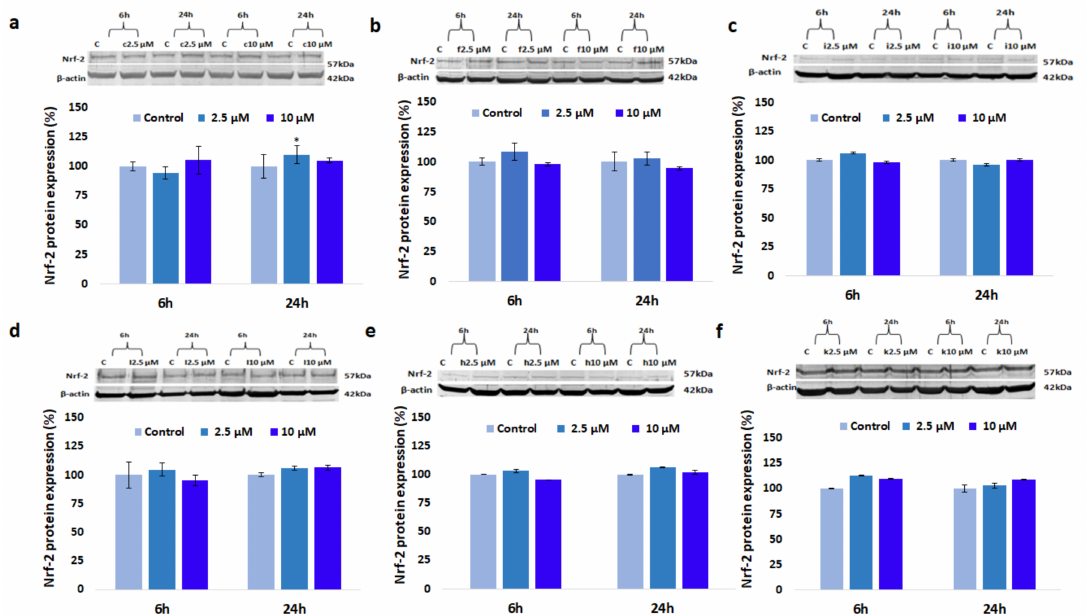
Figure 5. Nrf-2 protein expression in SVEC4-10 cells in the presence of increased concentrations of ( a ) GdDOTP citric acid, 2.5 mg · mL − 1 CS; ( b ) GdDOTP acetic acid, 2.5 mg · mL − 1 CS; ( c )